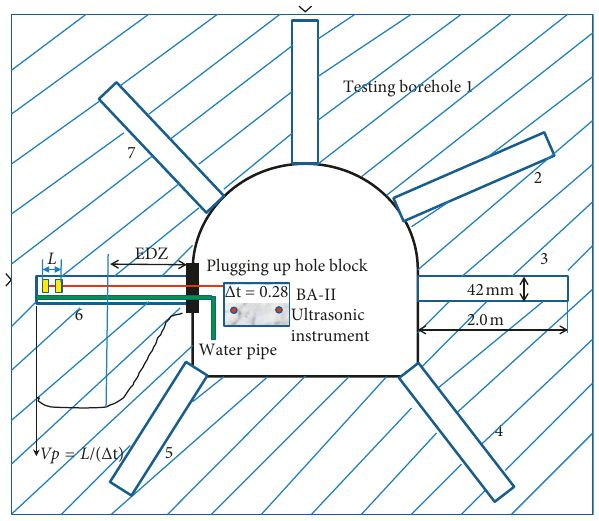
Figure 3: Arrangement of the monitored boreholes around the roadway.